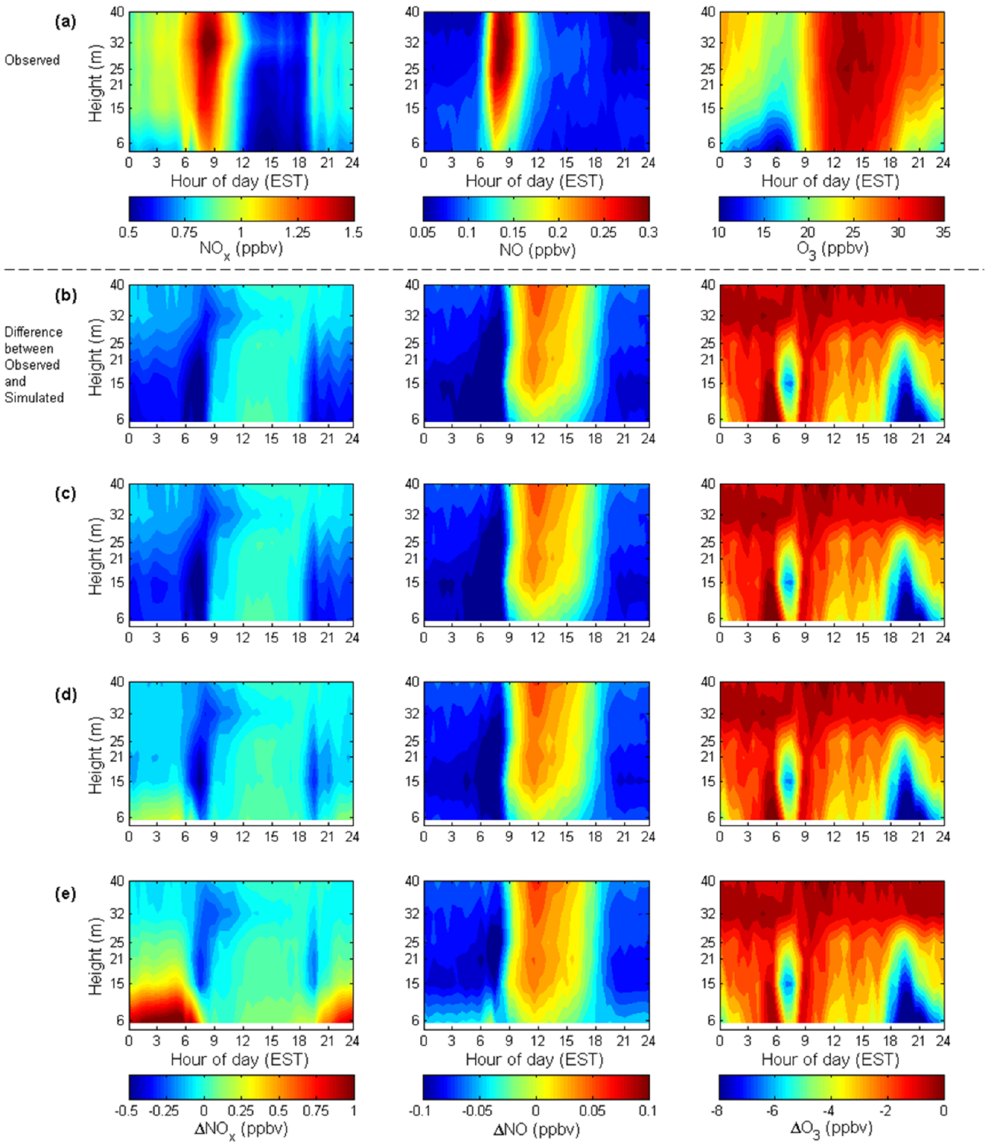
Fig. 9. (a) The observed mean diurnal mixing ratio profiles of NO x , NO , and O 3 . Plots (b) through (e) depict the difference between the observed and simulated mean ( ∆ = simulated − observed) diurnal cycle of the mixing ratio profiles of these gases as a function of soil NO emission for August 2008. (b) Case for “zero” soil emission. (c) Case for default soil emission (1 × , 0.07 ngNm − 2 s − 1 ; see Table 1). (d) Case for 10 times the default soil emission (10 × ). (e) Case for 25 times the soil emission (25 × ).